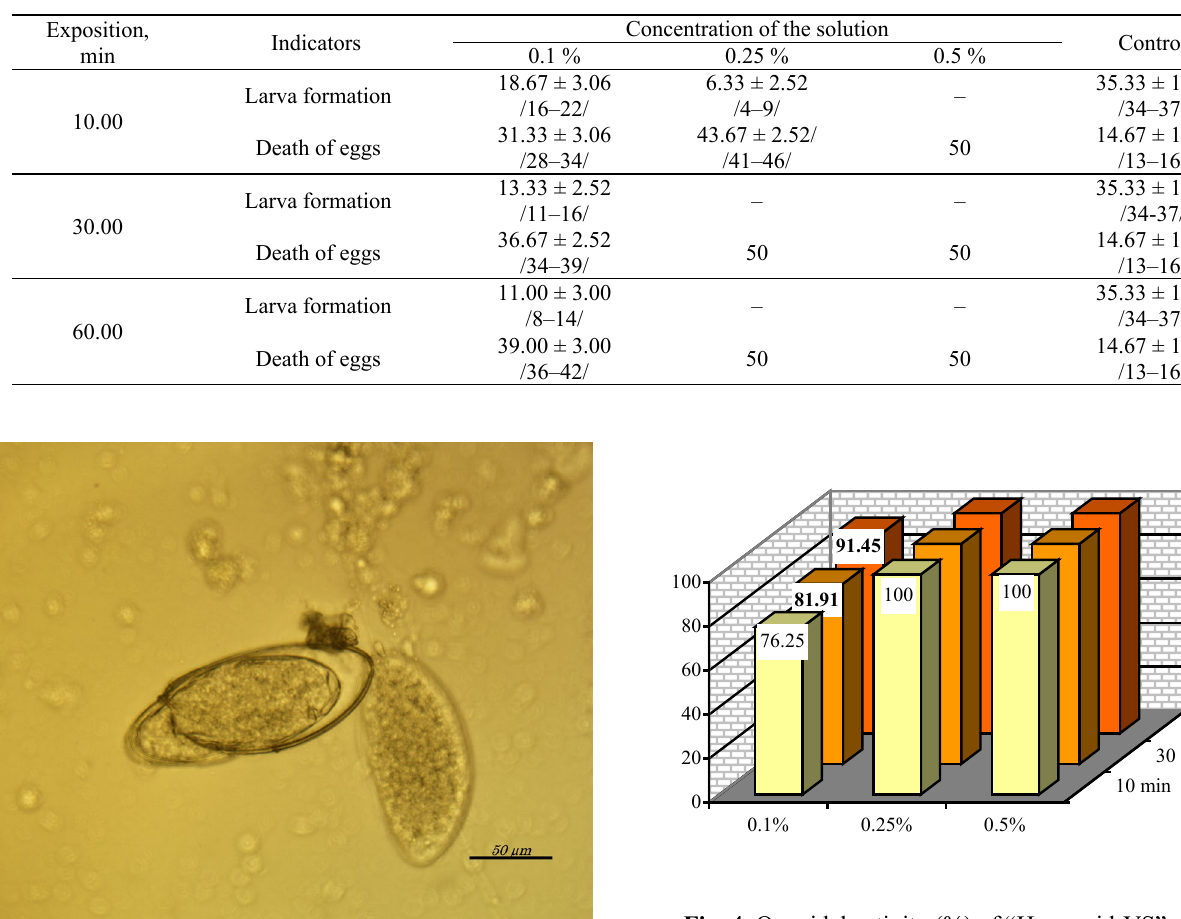
Fig. 4. Ovocidal activity (%) of “Hermecid-VS” against eggs of Passalurus ambiguus